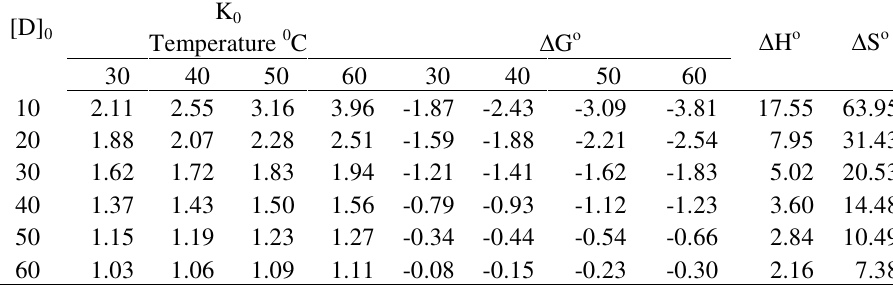
Table 6. Equilibrium constant and thermodynamic parameters for the adsorption of Rhodamine B dye onto